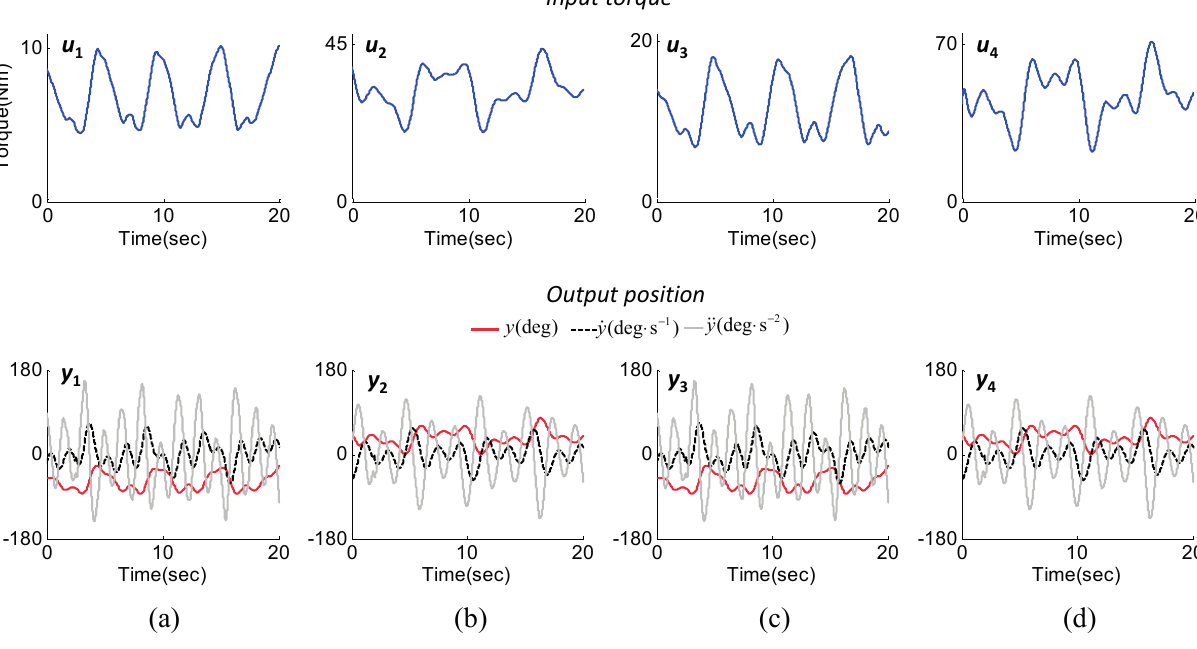
Figure 5. Input (joint torque) and output (joint kinematics) data recorded in the identification experiments for subject 1. ( a ) Step 1 (knee joint data; exoskeleton); ( b ) Step 2 (hip joint data; exoskeleton); ( c ) Step 3 (knee joint data; combined human-exoskeleton system); ( d ) Step 4 (hip joint data; combined human-exoskeleton system). Table 3. Parameter identification results for the exoskeletal robot ( J (kg·m 2 ), X (kg·m), Y (kg·m)).